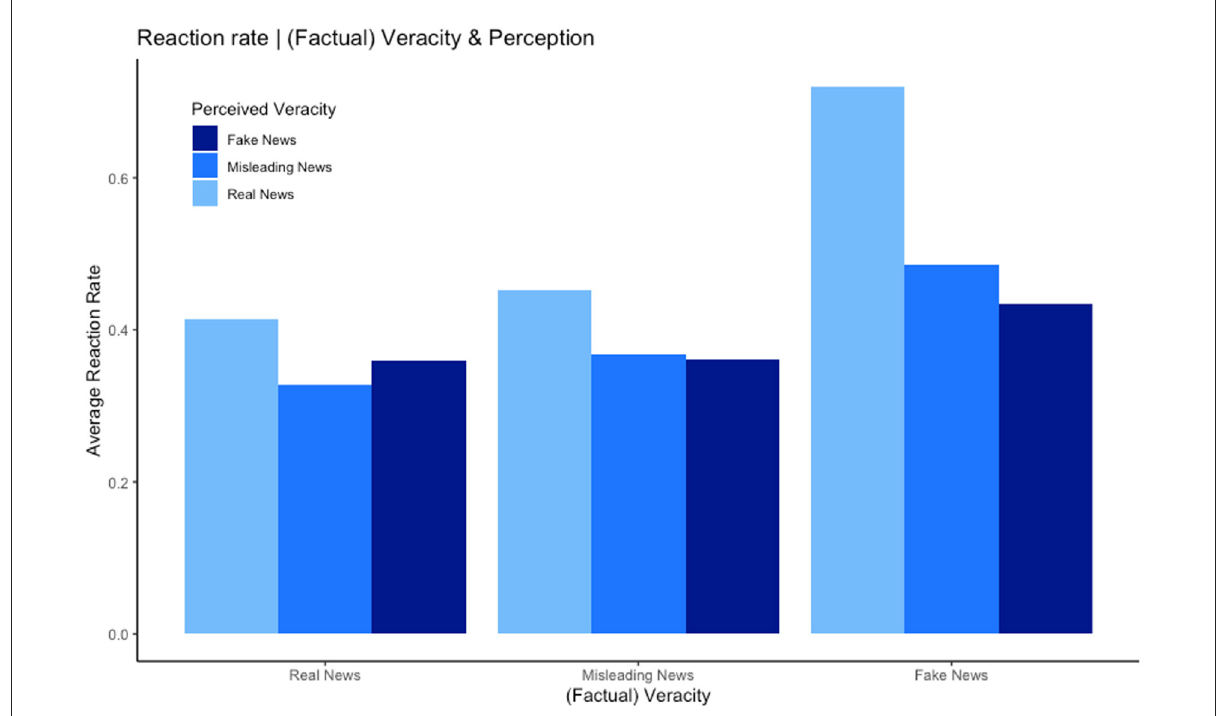
FIGURE3 Hypothesis 3—Reaction rate per (categorized) perceived and factual veracity.